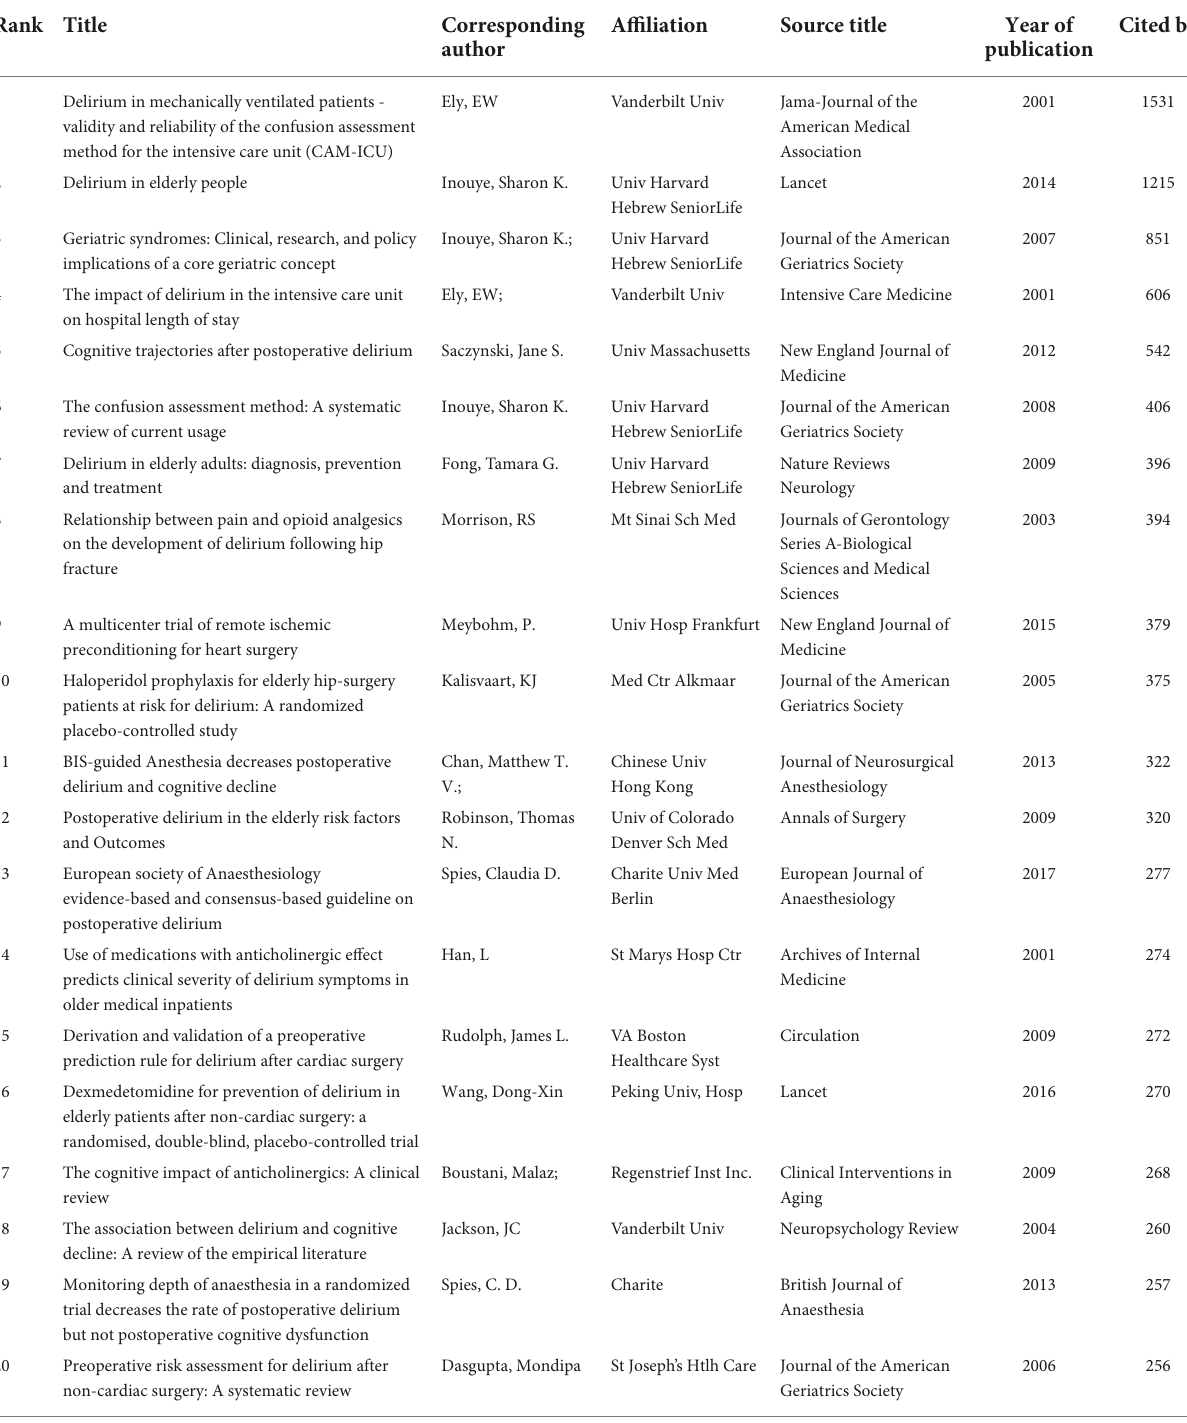
TABLE 6 The top 20 highest-cited articles on postoperative delirium